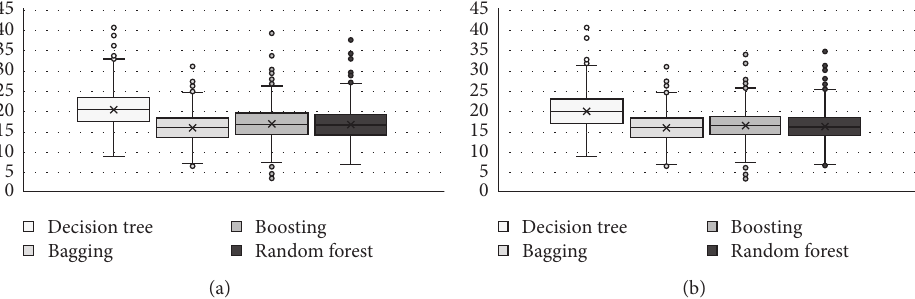
Figure 1: MAPE (a) and COD (b) main error measures of the four techniques (decision tree, bagging, boosting, and random forest) corresponding to the 433 municipalities in Spain.